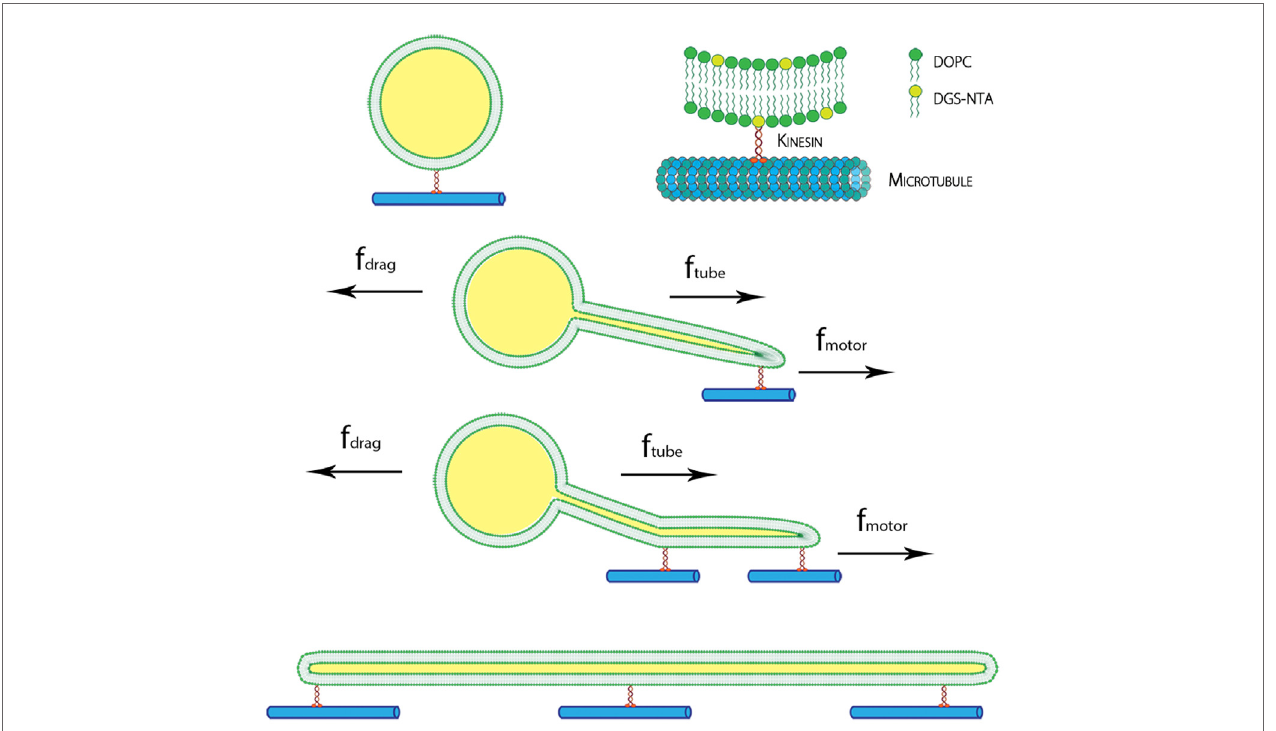
FigUre 1 | schematic of the kinesin-lipid anchor system and formation of lipid nanotube . DGS-NTA lipids were attached to kinesin motors, which bind to immobilized microtubule on glass. With an applied force by inducing flow, GUVs moved along the direction of flow and lipid nanotubes were pulled out by the kinesins. Multiple anchors of DGS-NTA stabilized the lipid nanotubes seen in tethered GUVs and